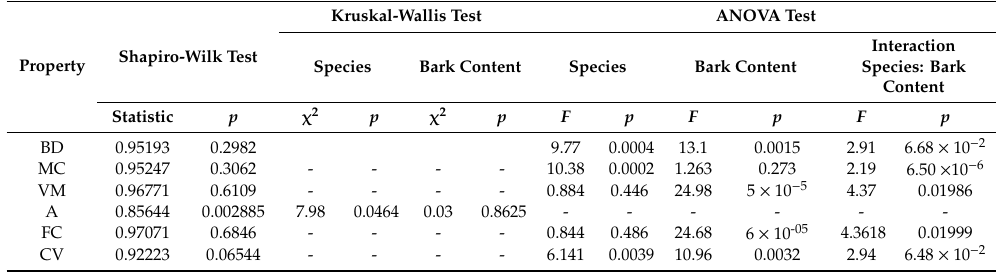
Table 3. Normality tests and statistical analysis of bulk density, proximal analysis, and calorific value of four oak species and bark content.